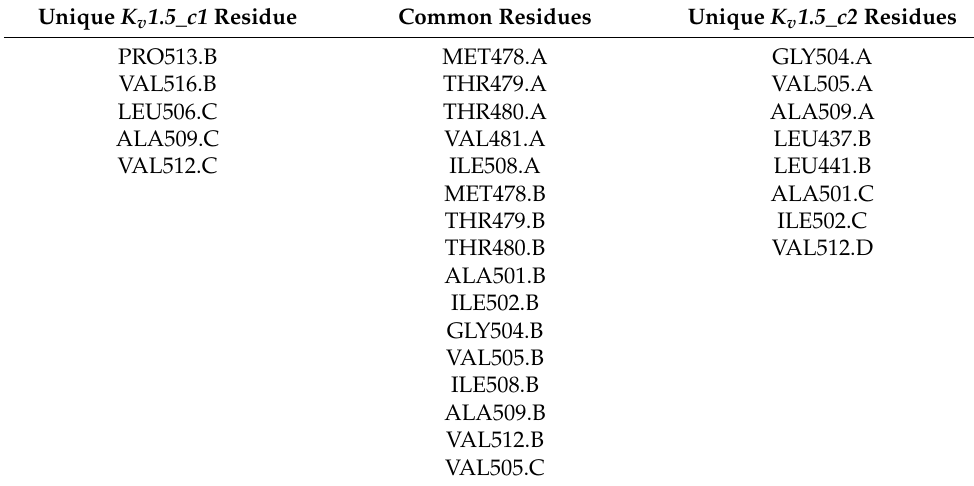
Figure 5. Physicochemical characterization of flecainide binding site (BS) . The flecainide BSs were computed in terms of ( a ) volume, ( b ) area, ( c ) hydrophobicity proportion, ( d ) Monera hydrophobicity score and ( e ) the proportion of apolar atoms in K v 1.5 and Na v 1.5 along three replicas of molecular dynamics simulations. The colored points and vertical lines stand for the median value and the interquartile range (IQR) of each property measured, respectively. **** represent p -value adjusted (Bonferroni) = 0 on a Wilconsox Rank Sum test. Table 1. BS residues of K v 1.5 centroids. Description of the binding site residues from centroid structures in K v 1.5 obtained by clustering based on physicochemical properties. For K v 1.5, centroid structures correspond to K v 1.5_c1 and K v 1.5_c2 from clusters 1 and 2,